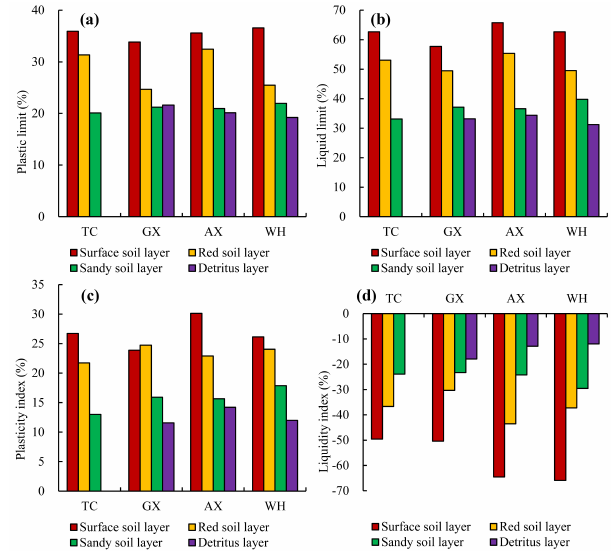
Figure 3. Averages of different particle-size distributions for differ- ent weathering profiles of the four collapsing gullies. (a) Tongcheng County, (b) Ganxian County, (c) Anxi County and (d) Wuhua County.